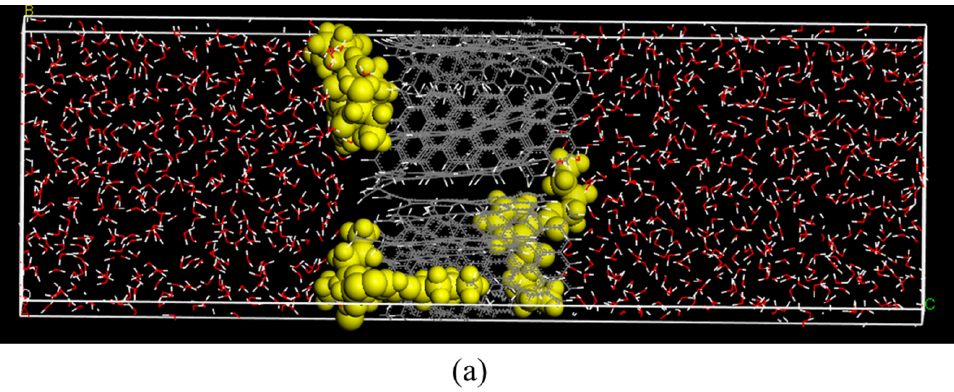
Figure 5. Equilibrium adsorption capacity values of five PAEs in systems with different ethanol